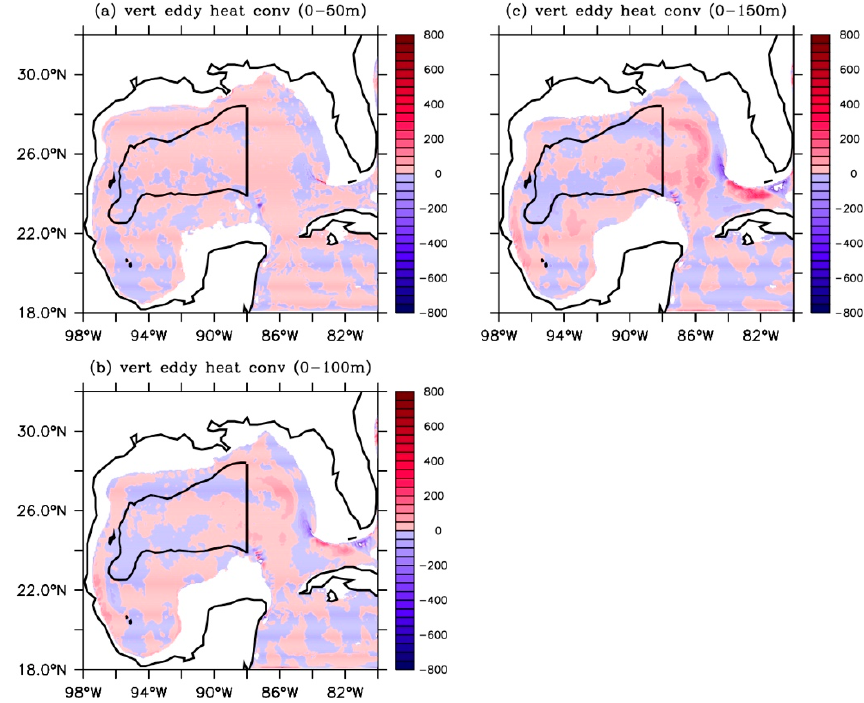
Figure 9. Same as Figure 8, except for mean vertical eddy heat flux convergence.